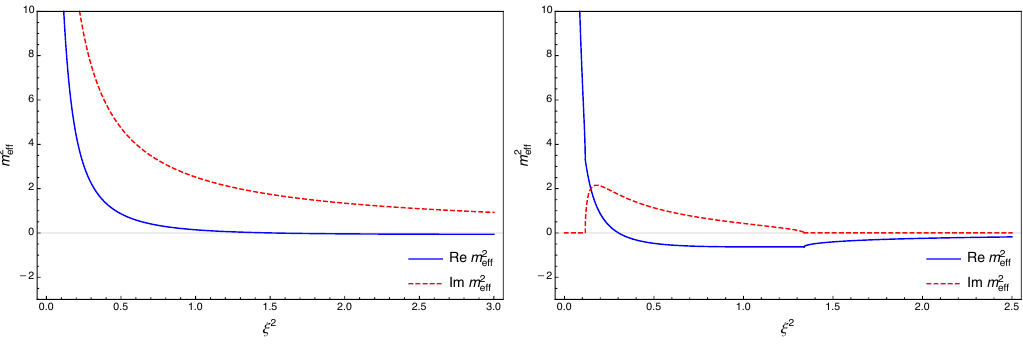
Figure 9 . Effective mass-squared as a function of ξ 2 using the W − 1 branch of the Lambert function. Left: massive theory. Right: tachyonic theory. In both cases the limit ξ 2 → 0 does not give the local theory; the mass-squared